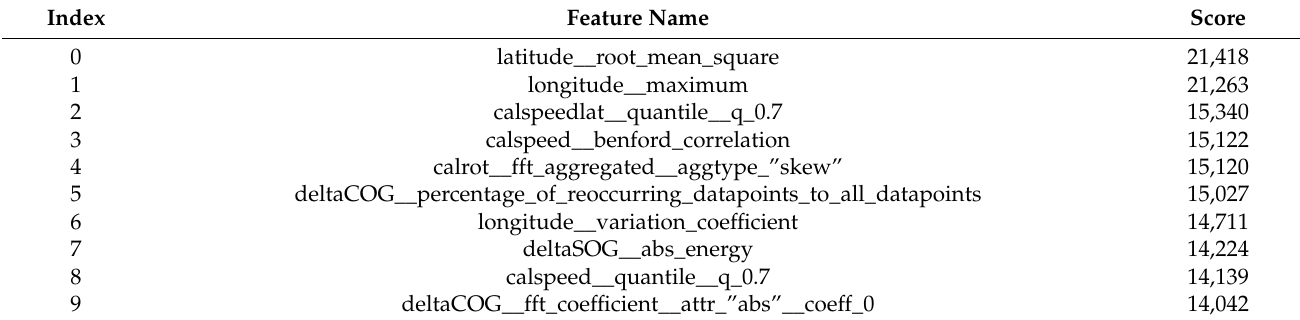
Table A2. Top 40 most important features on global